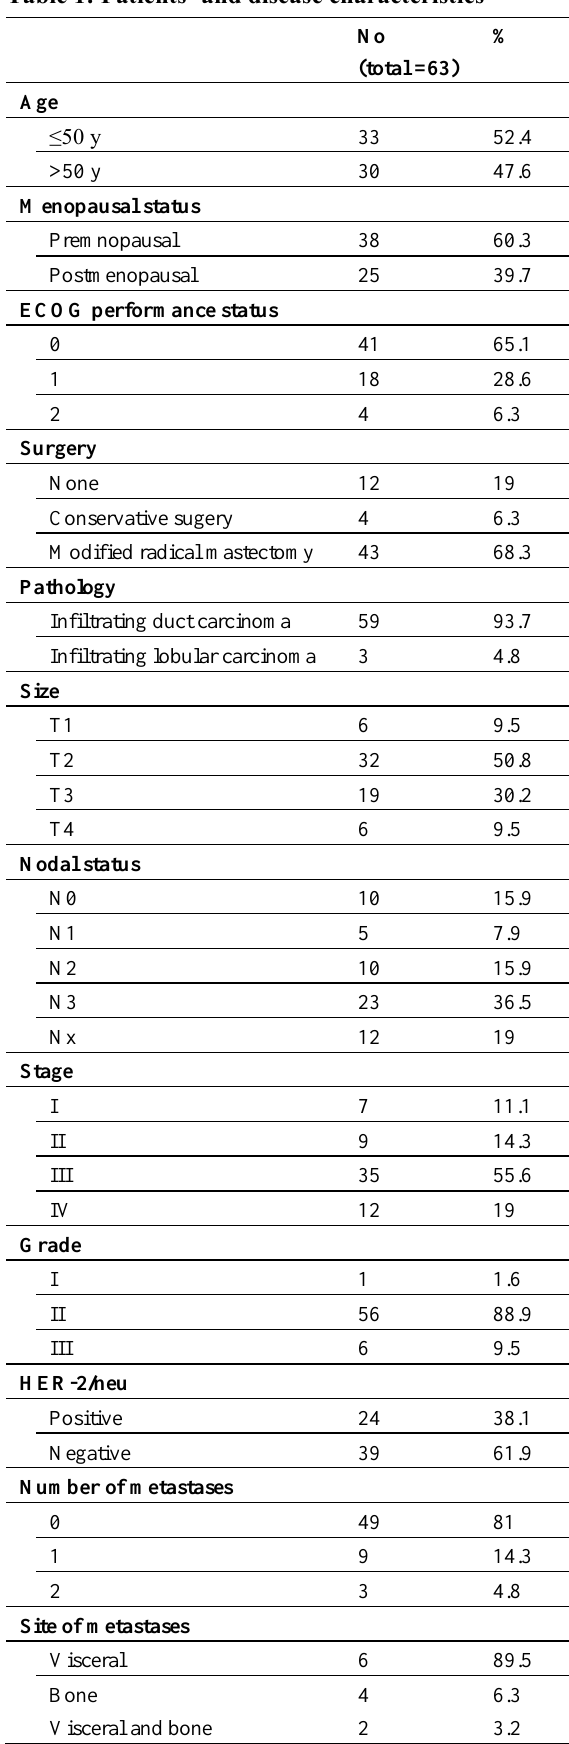
Table 1: Patients’ and disease characteristics